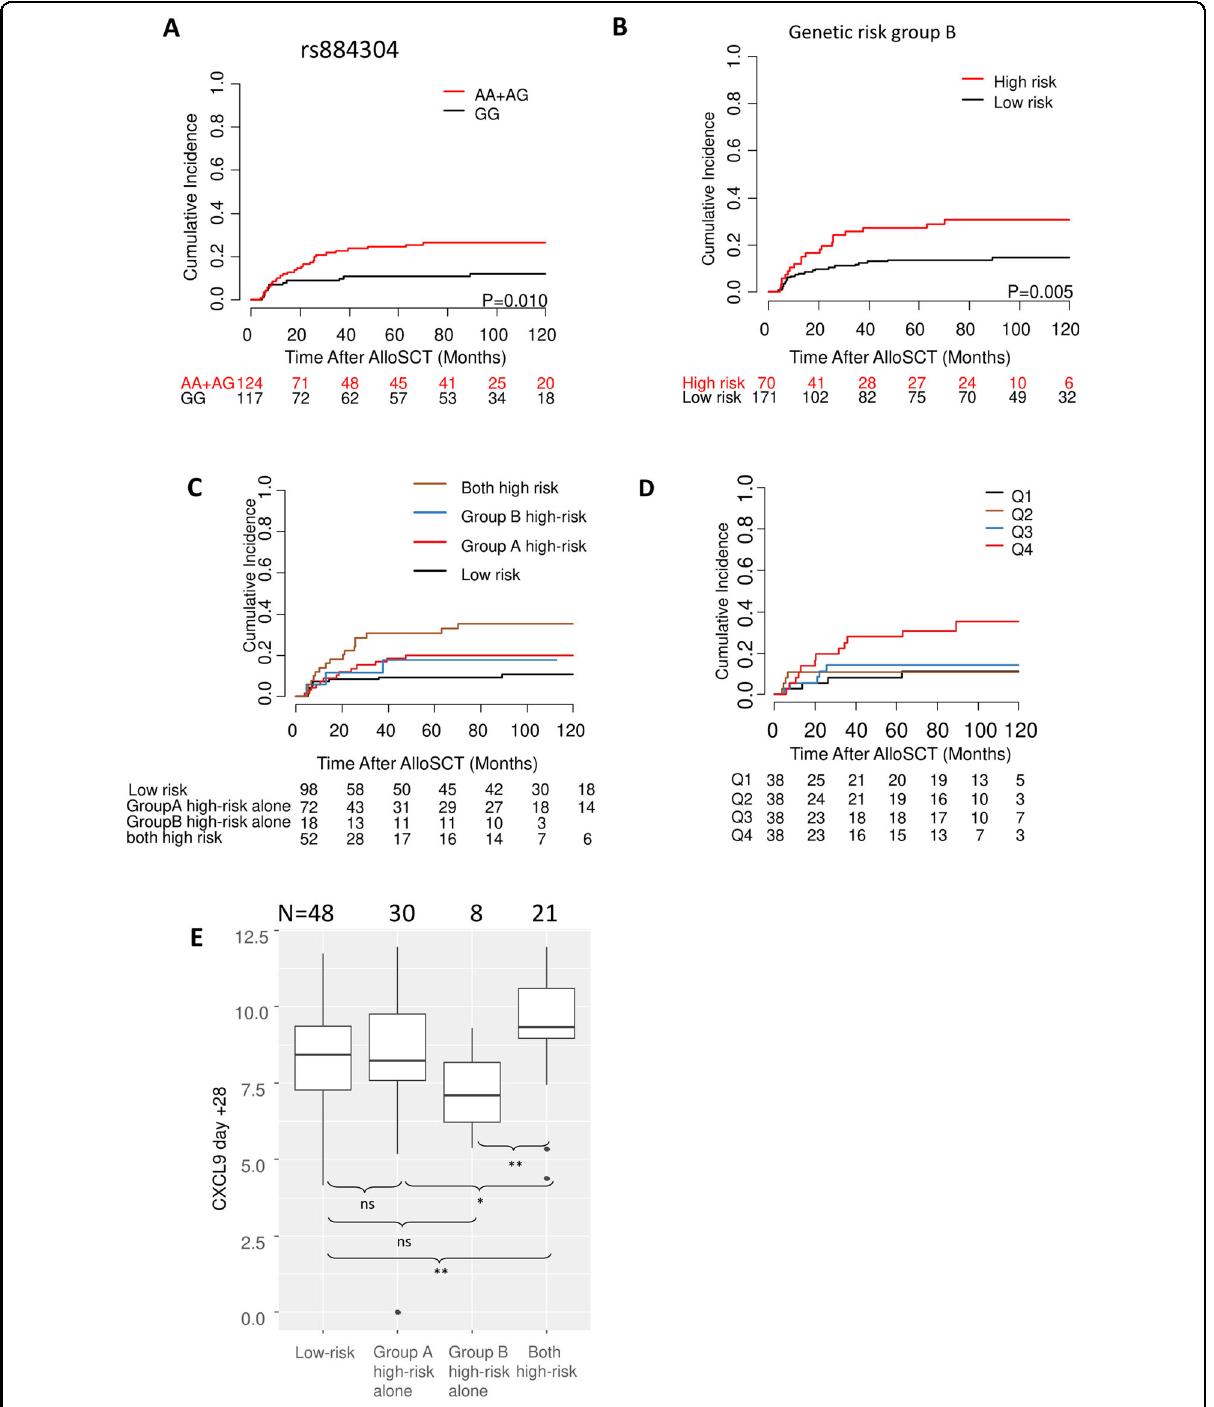
Fig. 1 Association of single-nucleotide polymorphisms (SNPs) in CXCR3 ligand genes and serum chemokines with the incidence of severe chronic graft-versus-host disease (GVHD). A Carriers of the variant allele for CXCL9 polymorphism rs884304 (AA + AG) were associated with a signi fi cantly higher incidence of severe chronic GVHD in the training cohort. B Effects of the three candidate SNPs for genetic risk group B on the incidence of severe chronic GVHD after alloSCT. Genetic risk group B was based on rs3733236, rs4282209, and rs655328. C Association of severe chronic GVHD incidence with genetic risk groups A and B. D Association of serum CXCL9 levels with a cumulative incidence of severe chronic GVHD after alloSCT in the training cohort. E Association of day + 28 CXCL9 serum levels with genetic risk groups A and B. n.s. not signi fi cant; * P ≤ 0.05; ** P < 0.01; *** P <